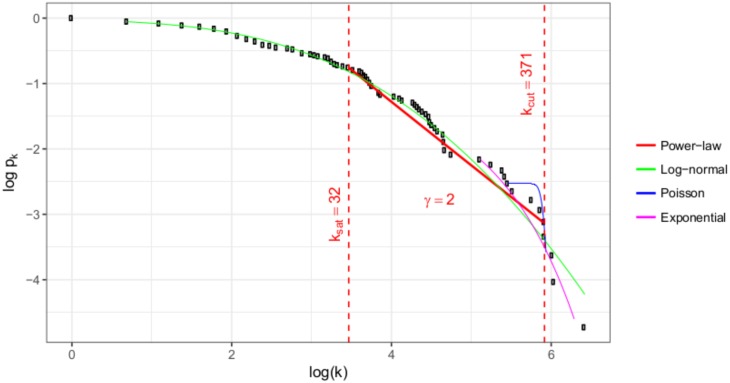
Distribution of the weighted degrees of the occupations.